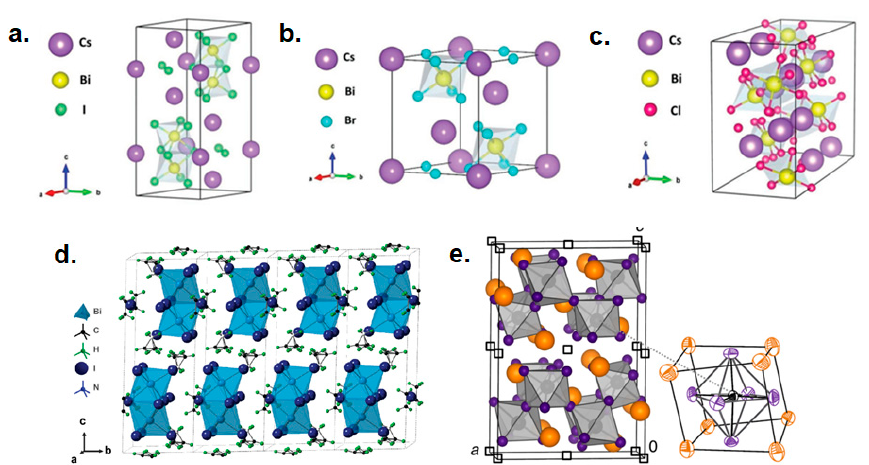
Figure 3. Crystal structure of the A 3 Bi 2 X 9 family: ( a ) Cs 3 Bi 2 I 9 , ( b ) Cs 3 Bi 2 Br 9 , ( c ) Cs 3 Bi 2 Cl 9 , ( d ) MA 3 Bi 2 Br 9 , and (e) Rb 3 Bi 2 I 9 . Adapted from [100–102].